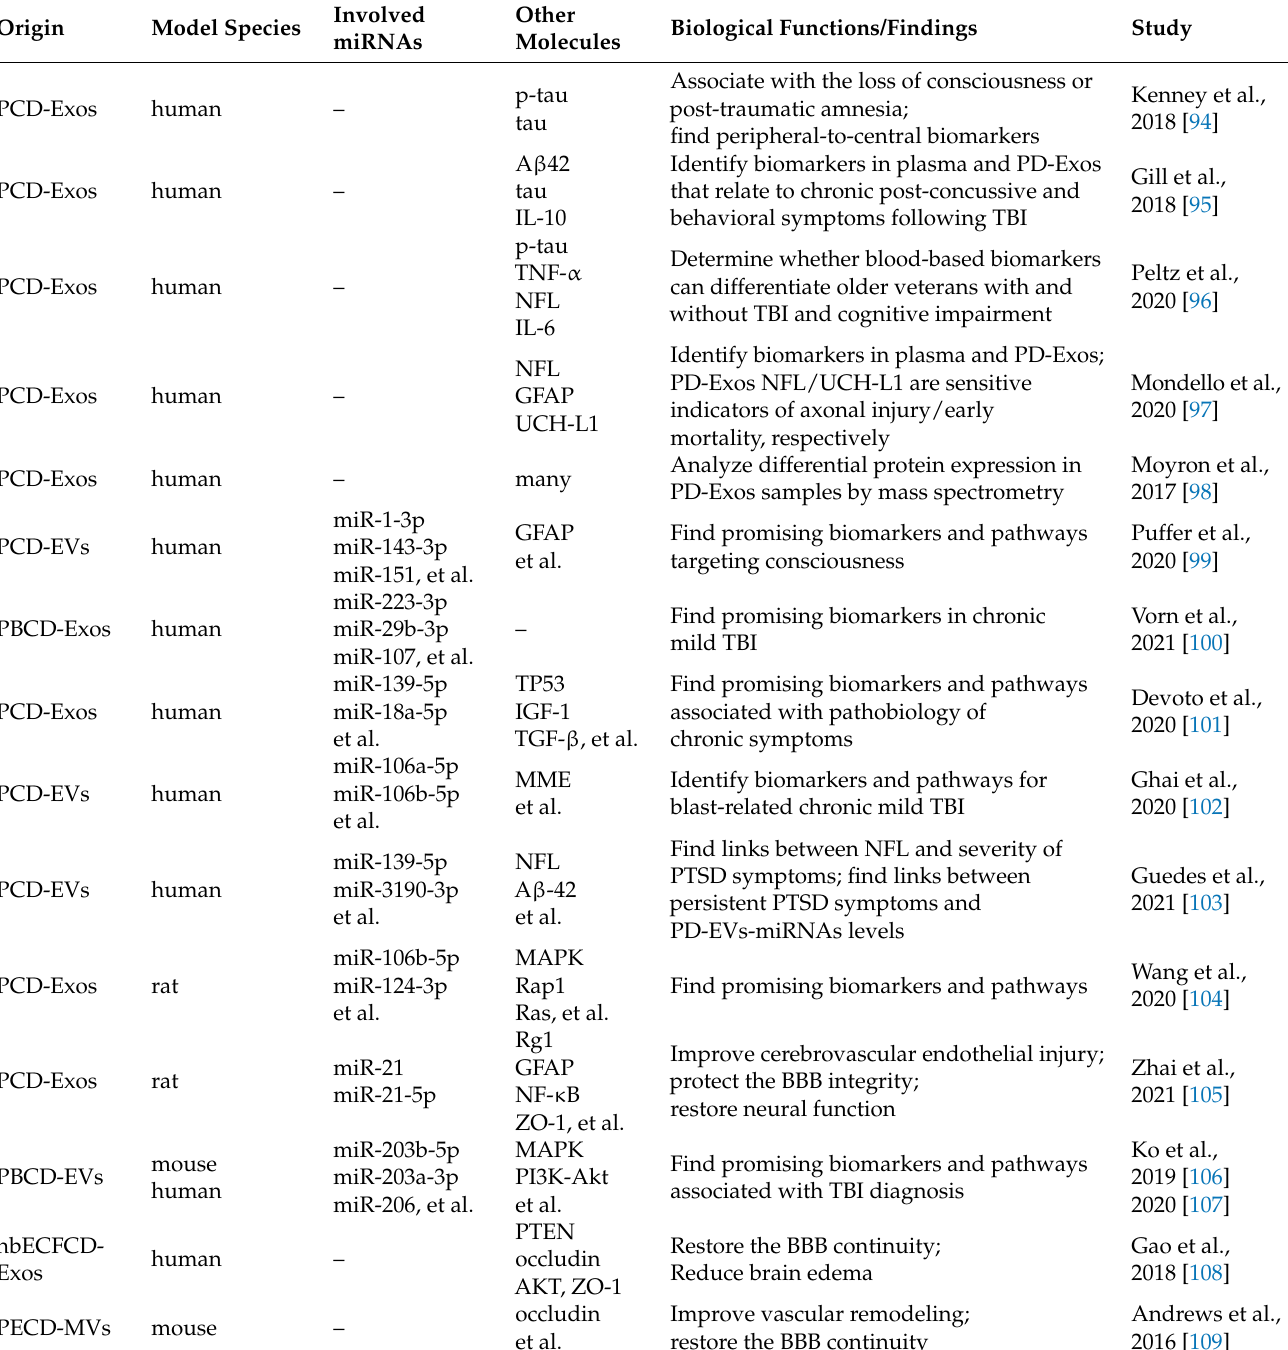
Table 6. Humoral cell-derived Exos/EVs and HCD-Exos/EVs-miRNAs studies in